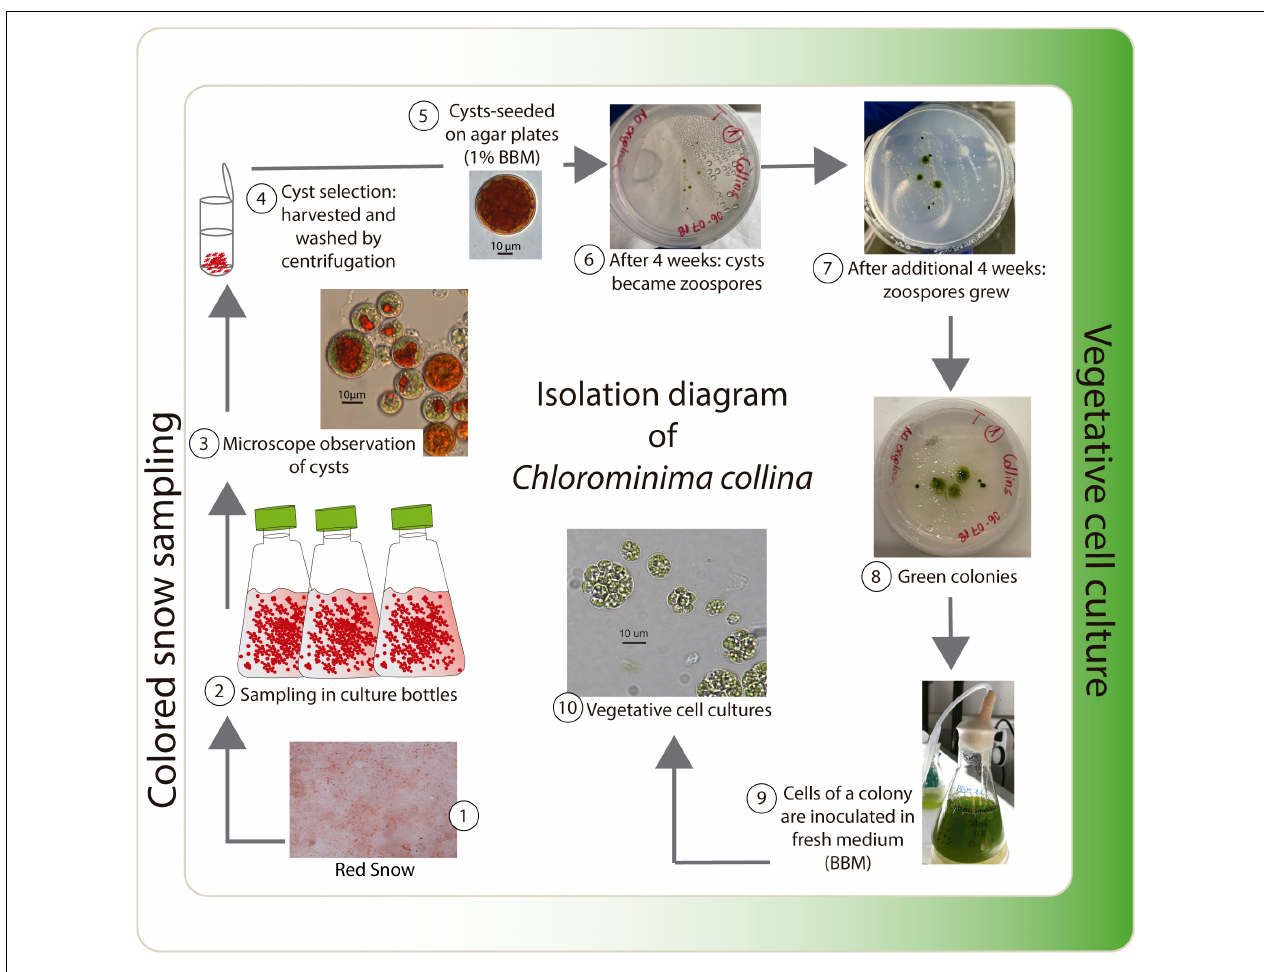
FIGURE 1 | Isolation diagram of Chlorominima collina CCAP